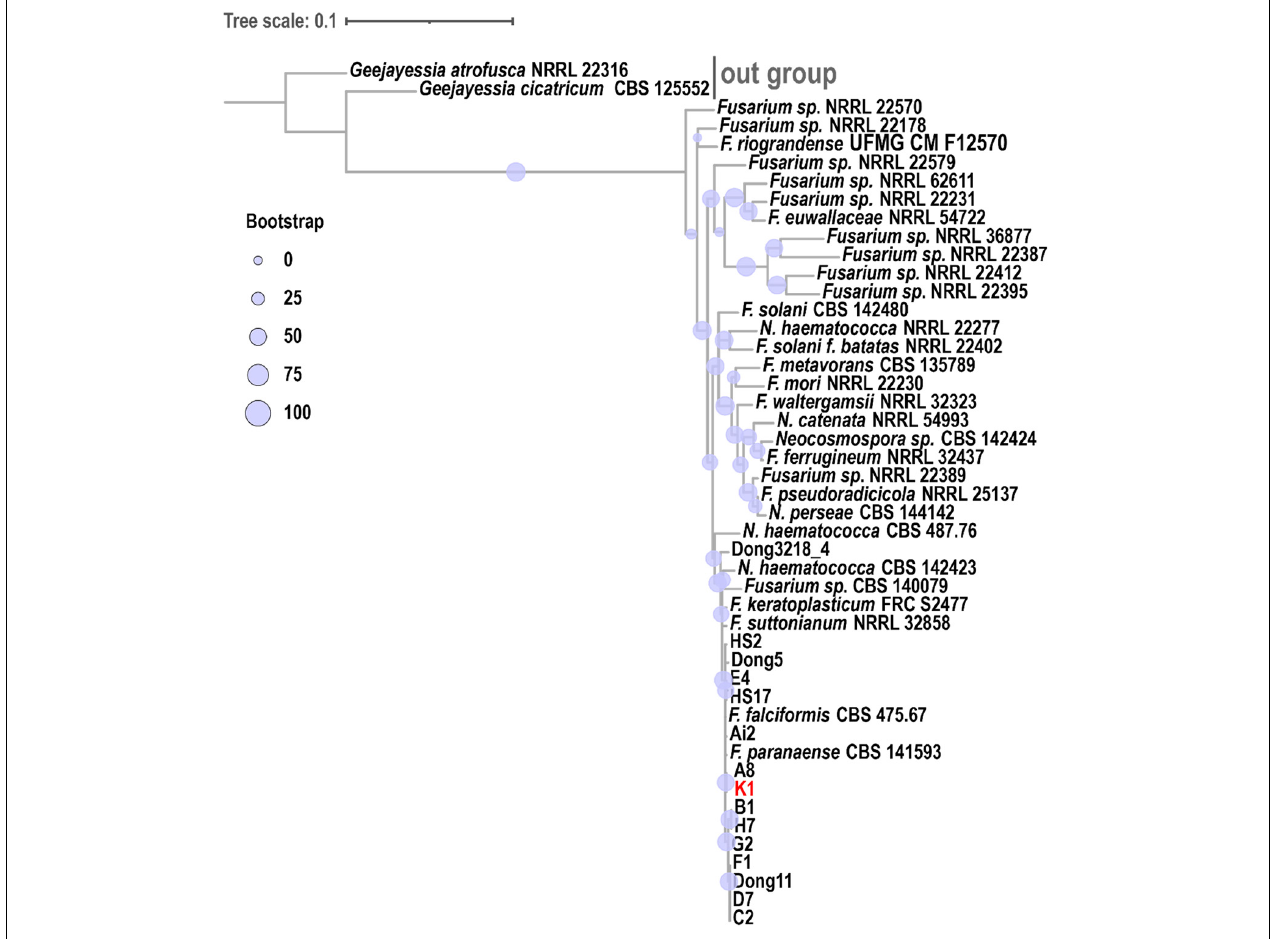
FIGURE 6 | Phylogenetic analysis of Fusarium solani K1 (FsK1). A phylogenetic tree was constructed using ITS, TEF1 α , and RPB2 sequences. FsK1 (K1 in the figure) exhibited the closest relationship with F. paranaense and F. falciformis , both belonging to the F. solani species complex. The phylogenetic relationship among fungal species was inferred using the maximum likelihood method with the TIM2e + I + G4 model and 1000 bootstraps. A consensus tree was visualized and edited in iTOL